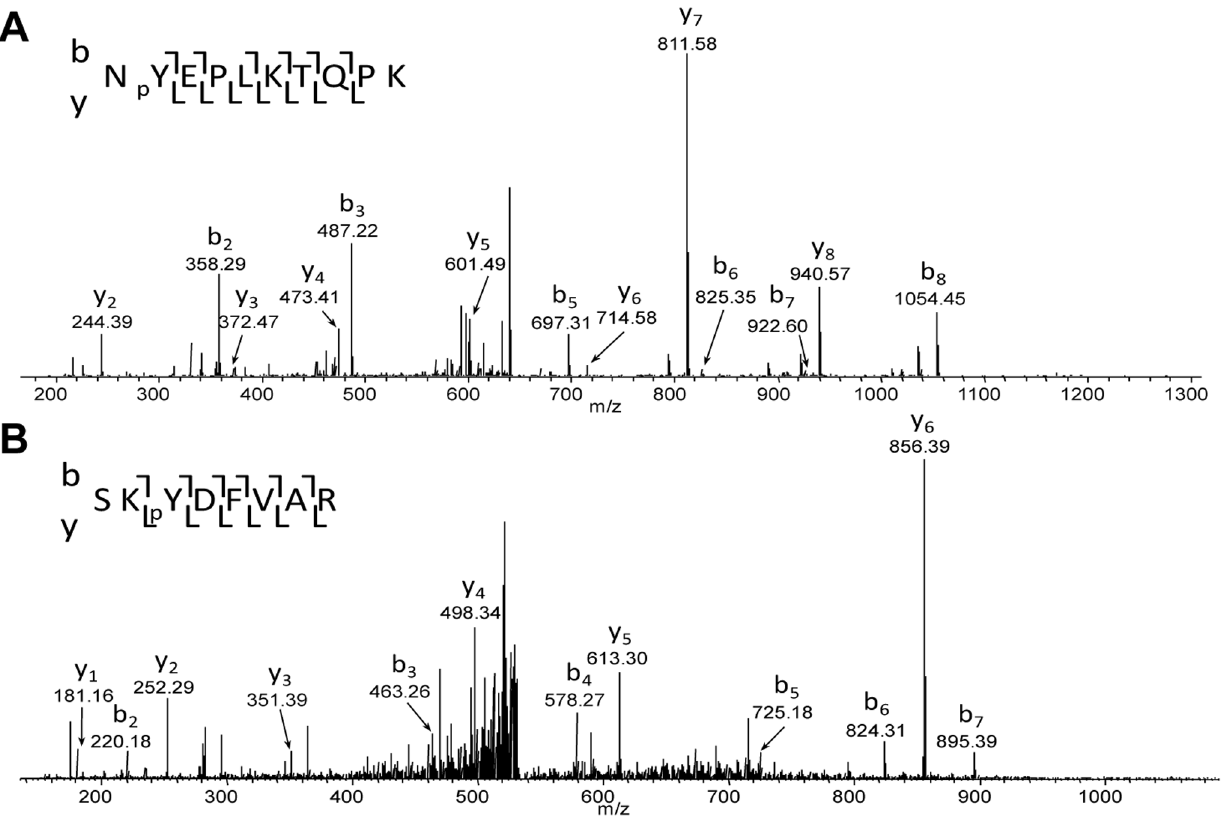
Figure 2. Representative mass spectra for identification and site localisation of tyrosine phosphorylation on Eps8. A) Eps8 is phosphorylated on residue 525. B) Eps8 is phosphorylated on residue 540. pY indicates phosphotyrosine.